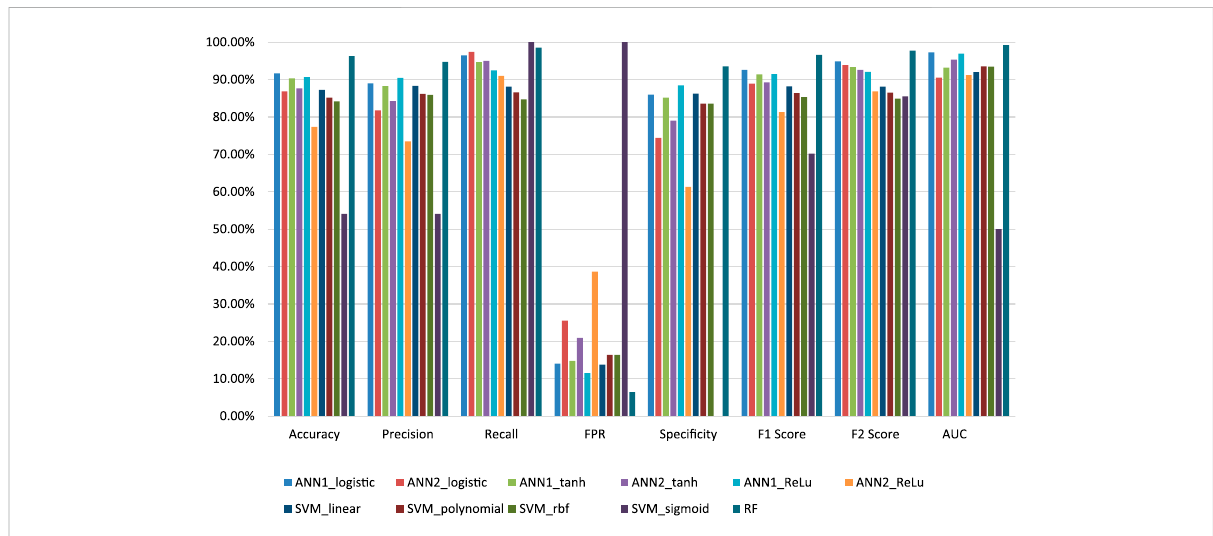
FIGURE 7 Graphical representation of the performance of all models for off-target prediction developed using three groups of machine learning techniques.